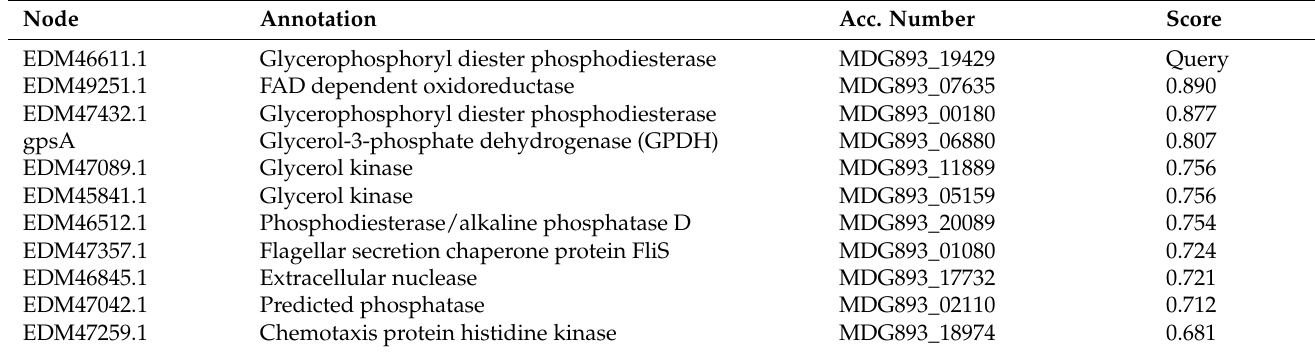
Table 1. M. algicola glycerophosphoryl diester phosphodiesterase (GDPD) potential protein interactions based on the STRING